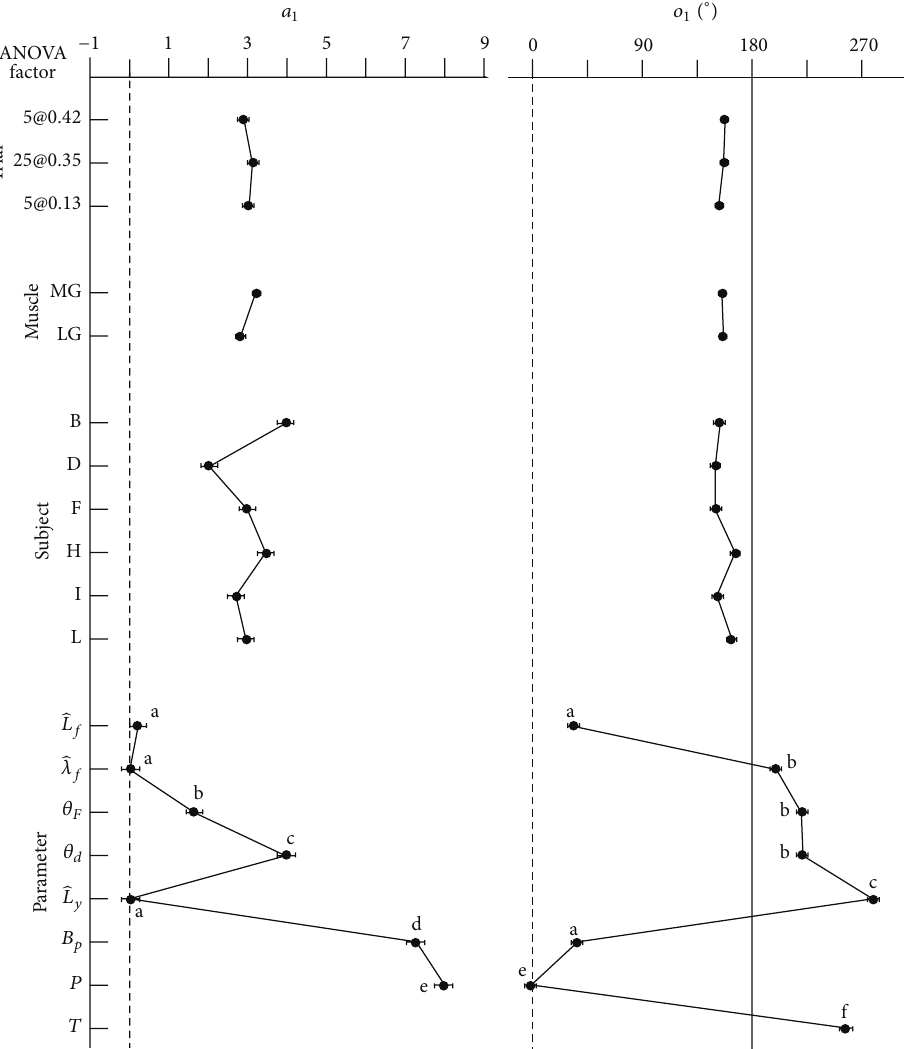
Figure 4: Main Effects Determined by ANOVA . The effects of the experimental factors on the coefficients 𝑎 1 and 𝑜 1 for the first harmonic in the Fourier series are shown. Points show the least-square mean ± SEM as determined by the ANOVA. 𝑎 1 for torque was not tested due to its magnitude being much larger than the other variables. Letters next to the symbols indicate parameters that were not significantly different from each other, as calculated in a post hoc Tukey